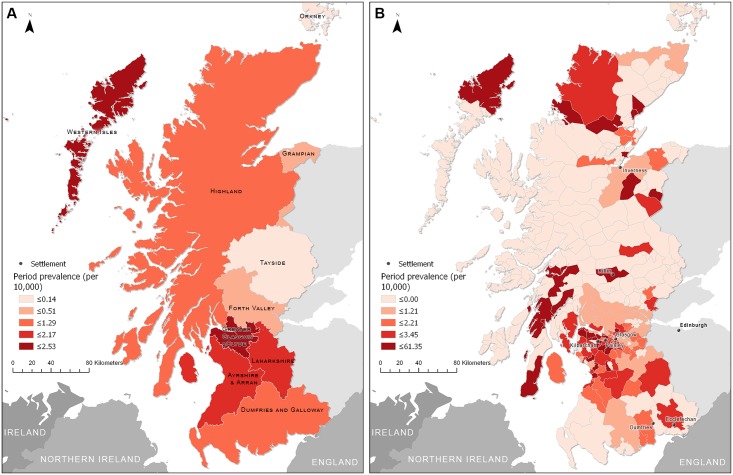
Period prevalence (SPP) of patients presenting with VS to the National Health Services of West of Scotland a) by NHS Health Boards with board names for reference and b) by postcode districts with settlements named within text.Note the different scales for period prevalence between a and b.